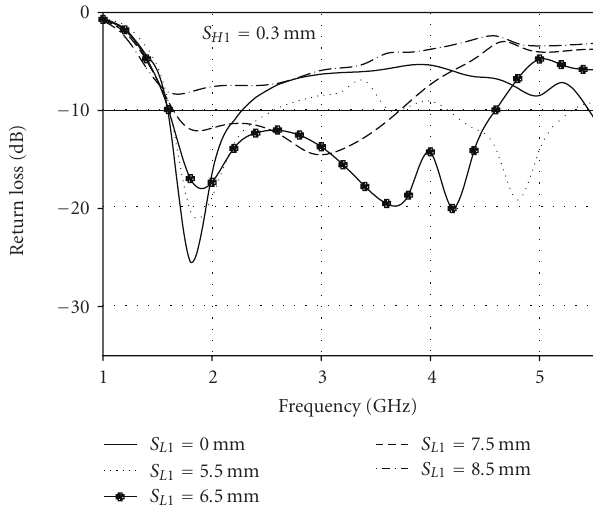
Figure 2: E ff ect of position of patch F 1 on return loss characteristics [ L = 67, W G = 67, L G = 29, L M = 15, W M = 3, W R = 7 . 5, L R = 19, S . 3, h = 1 . 6 (units in mm), ε R R = 11, H 1 = 0